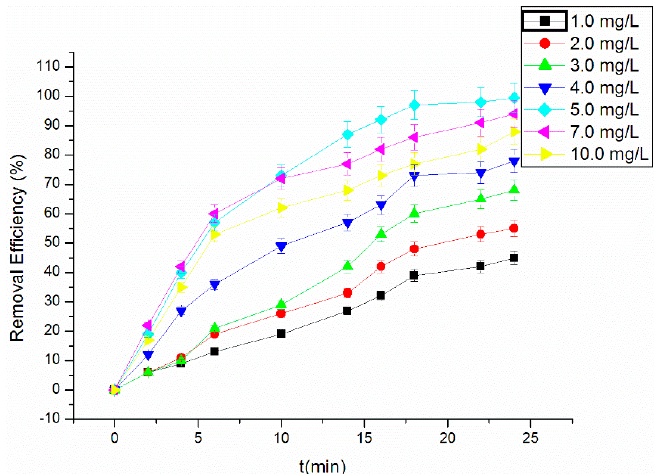
Figure 4. Effect of H 2 O 2 dosage on the RhB removal efficiency.